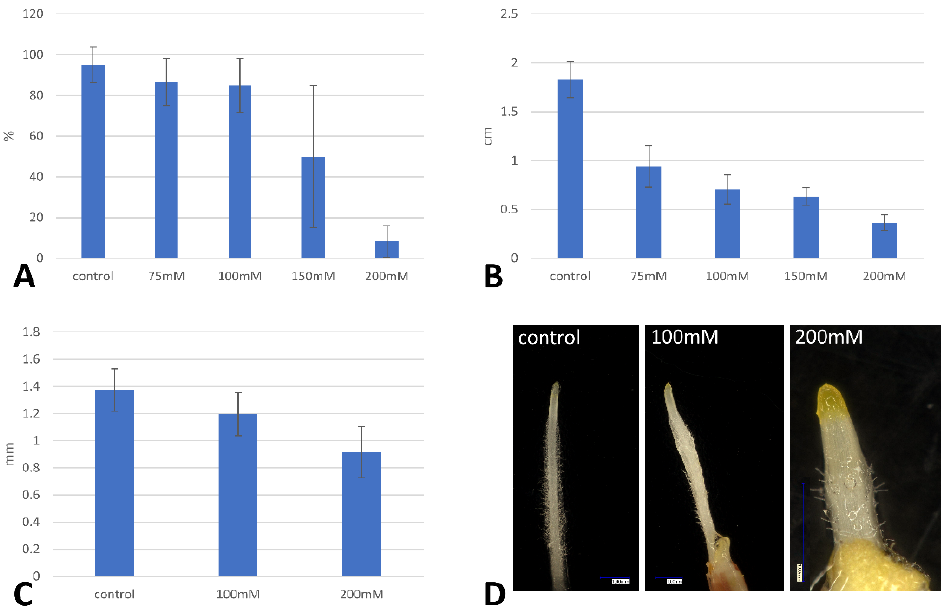
Figure 1. Effect of salinity (various concentrations of NaCl) stress on the percentage of seed germination ( A ), root length ( B ), root tip length ( C ) and root morphology ( D ) in Brachypodium. The results that are shown are the means ± SD from three replicates ( n = 3).